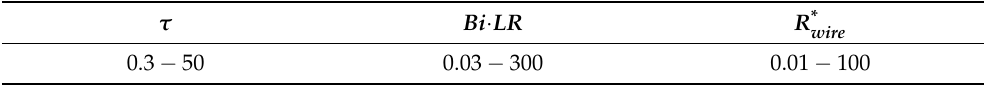
Table 4. Overall range for dimensionless